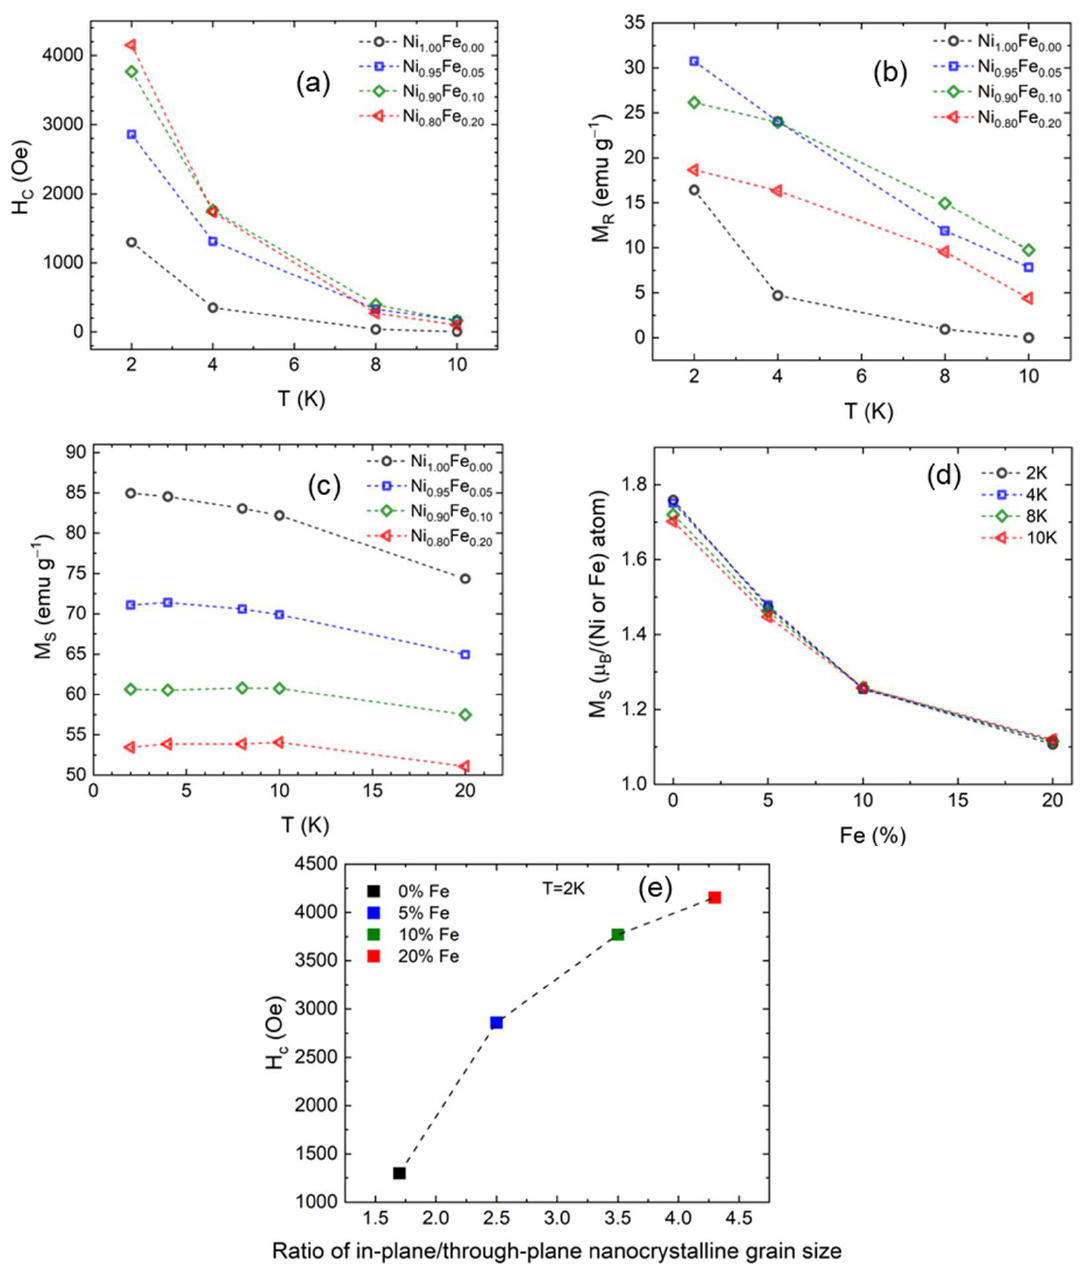
Figure 10. ( a ) Coercive field (H C ), ( b ) remnant magnetization (M R ), and ( c ) saturation magnetization (M S ) as a function of temperature for −20 % Fe samples; ( d ) saturation magnetization (M S ) in Bohr magnetons as a function of Fe % at low temperatures; and ( e ) plot of coercive field (H C ) versus ratio of in-plane/through plane nanocrystalline grain size for 0–20% Fe samples.